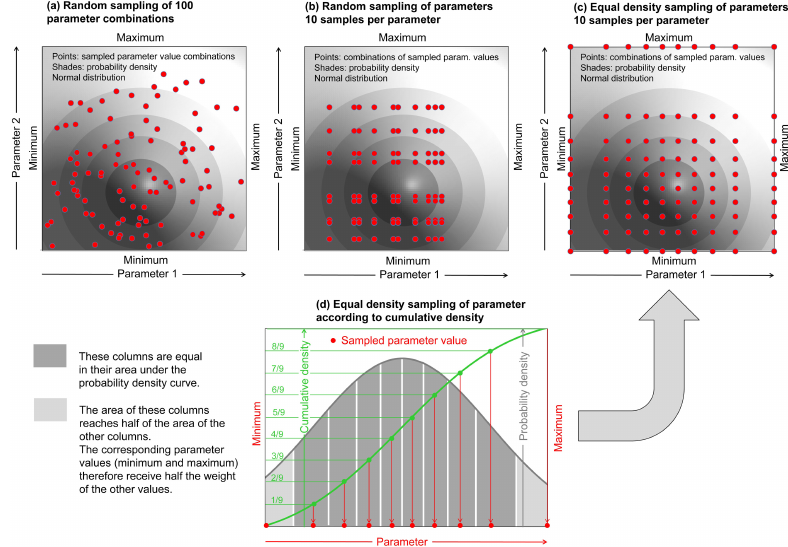
Figure 2. Sampling of parameters for computing slope failure probability. We test the sampling strategies (a) , (b) , and (c) . For clarity, sampling of two normally distributed arbitrary parameters is shown. In reality, we sample three parameters ( c (cid:48) , ϕ (cid:48) and truncated depth) according to different types of statistical distributions (see Sect. 4 for details). Panel (d) illustrates how the cumulative density function is employed for equal density sampling.